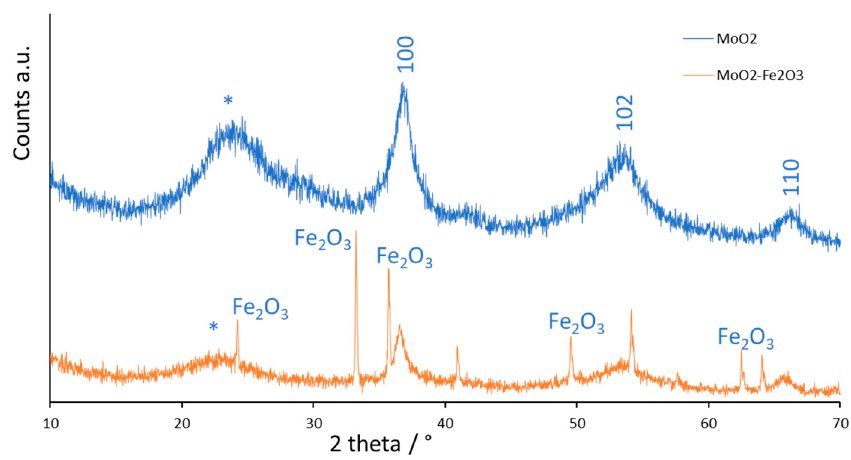
Figure 1. Powder X-ray diffraction (XRD) for the calcined MoO 2 and MoO 2 –Fe 2 O 3 nanoparticles (NPs) (* denotes silica diffraction peak from the support glass slide).